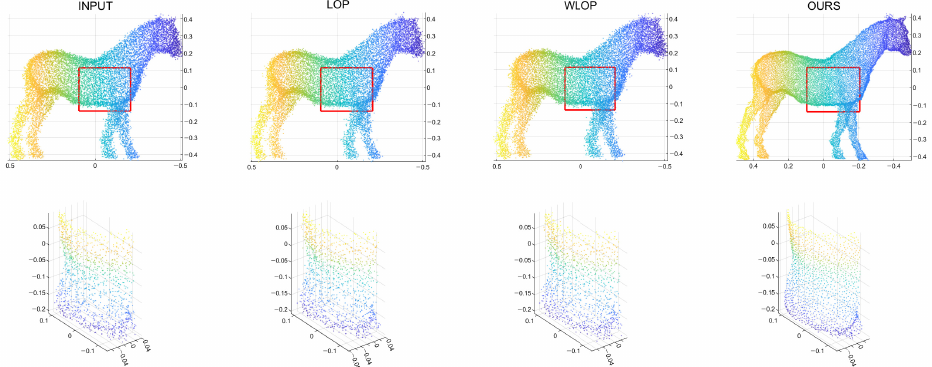
Figure 8. Qualitative results for an omnidirectional noise case (Horse). First column: input point cloud; second column: LOP; third column: WLOP; and fourth column: proposed method. The second row shows enlarged views of the first row.